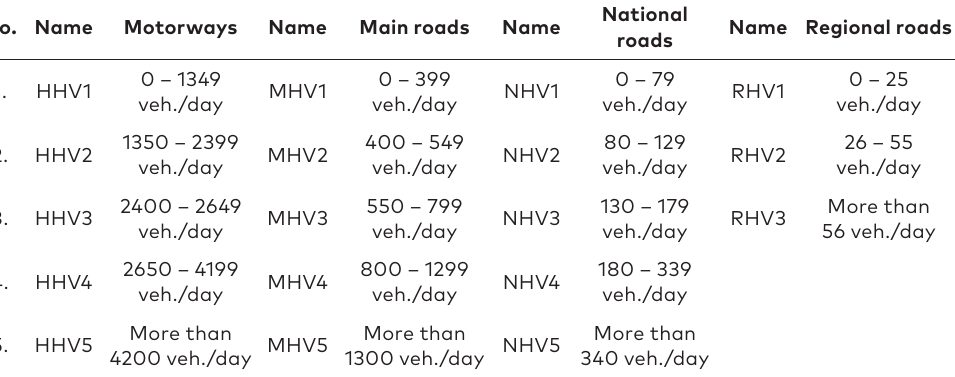
Table 3. Ranges of annual average daily heavy vehicle